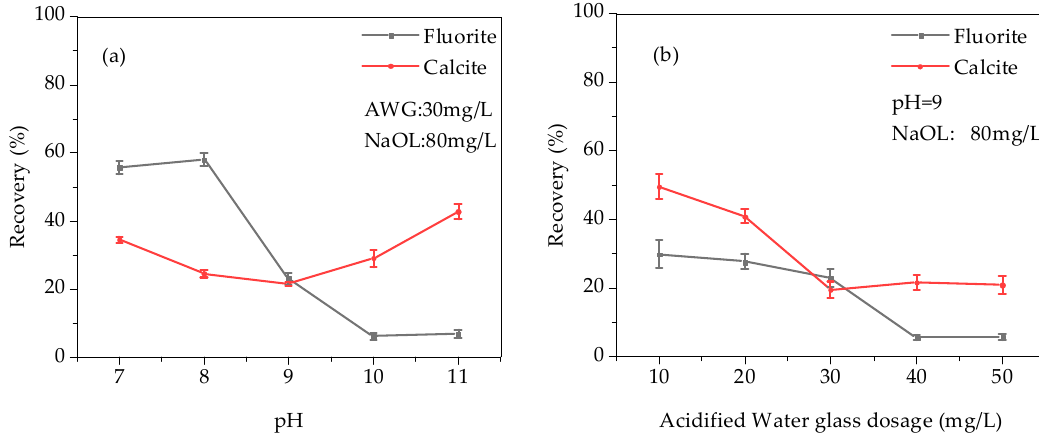
Figure 2. Effect of ( a ) pH value and ( b ) dosage of acidified water glass on the recovery of fluorite and calcite. Figure 3 shows the effects of NaF dosage and pulp pH on the flotation recovery of fluorite and calcite with NaOL as collector and AWG as a depressant. The results show that, with the increase in the amount of sodium fluoride, the flotation recovery of the two minerals gradually increases, and the flotation recovery of fluorite increases greatly. When the recovery of fluorite reached 88.72%, it was much higher than that of calcite at 34.85%. The difference between the flotation recovery of fluorite and calcite is the largest under neutral or weakly alkaline conditions, which is most conducive to the separation of fluorite and calcite.